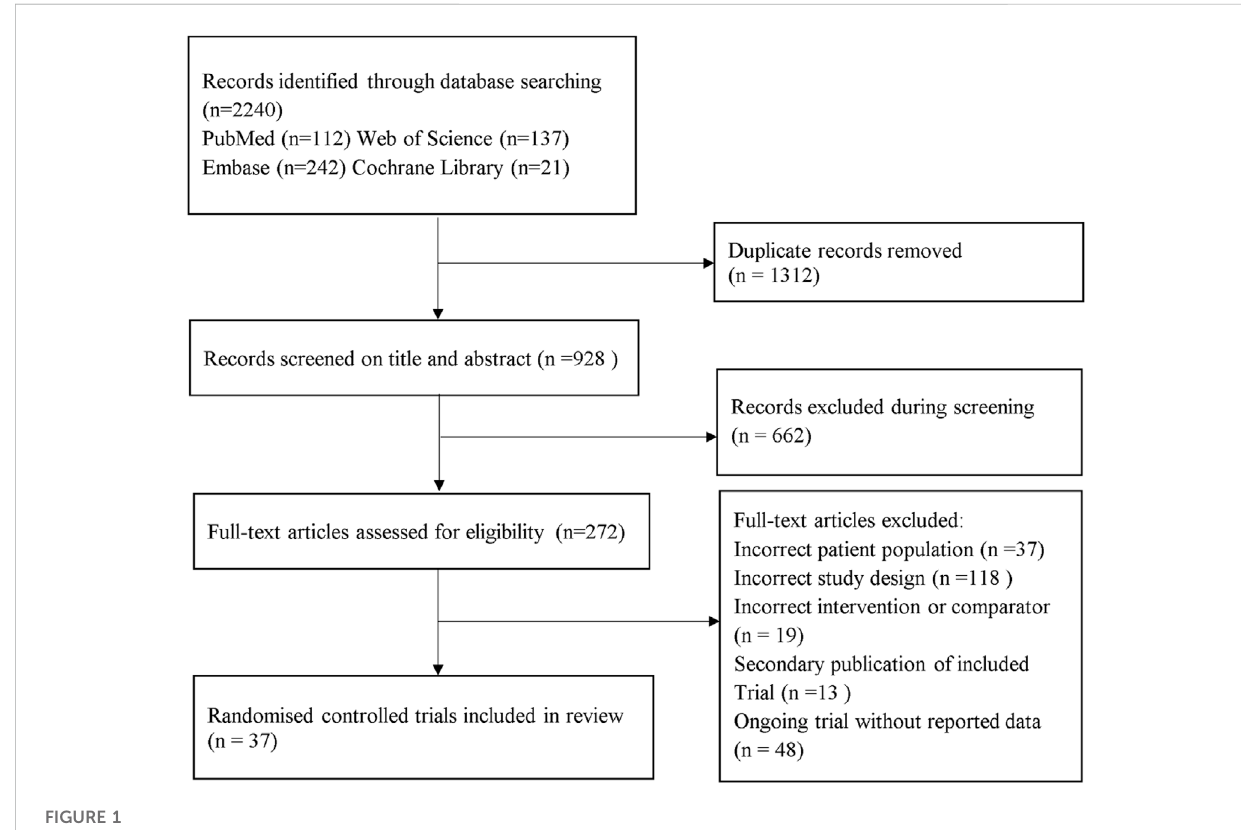
FIGURE 1 PRISMA fl ow